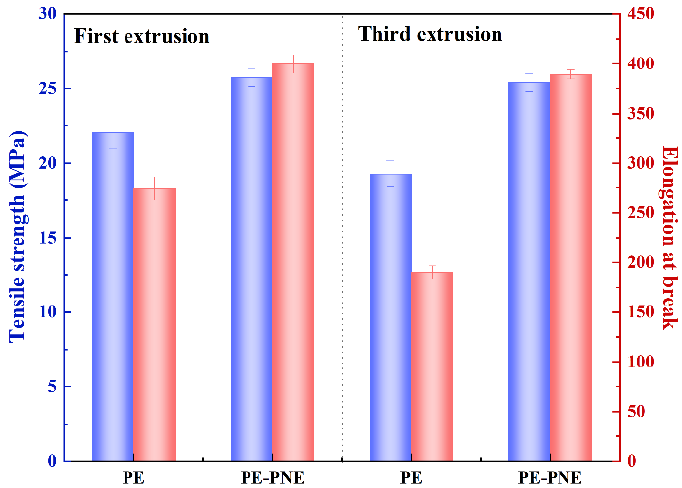
Figure 5. Tensile strength and Elongation at break of PE and PE-PNE samples vs. the number of extrusions.